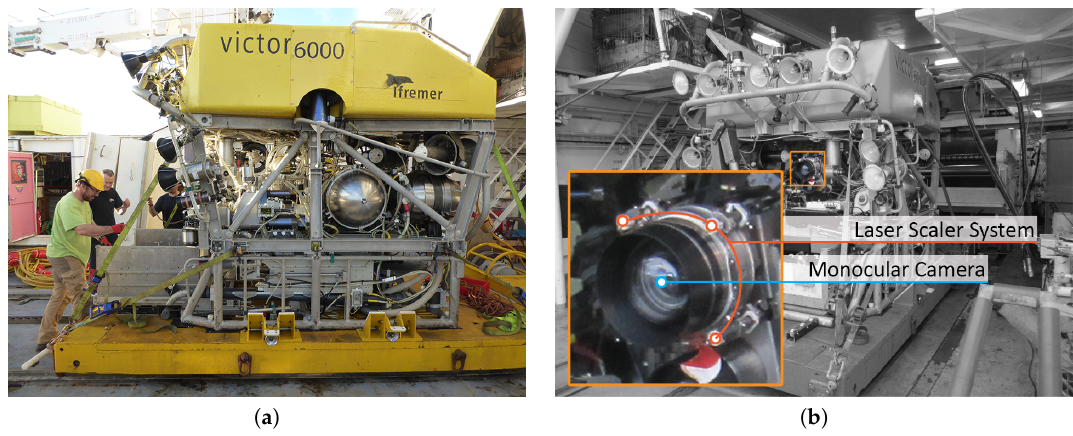
Figure 11. ( a ) ROV VICTOR 6000 (IFREMER) [73]. ( b ) Enlarged camera and laser system.